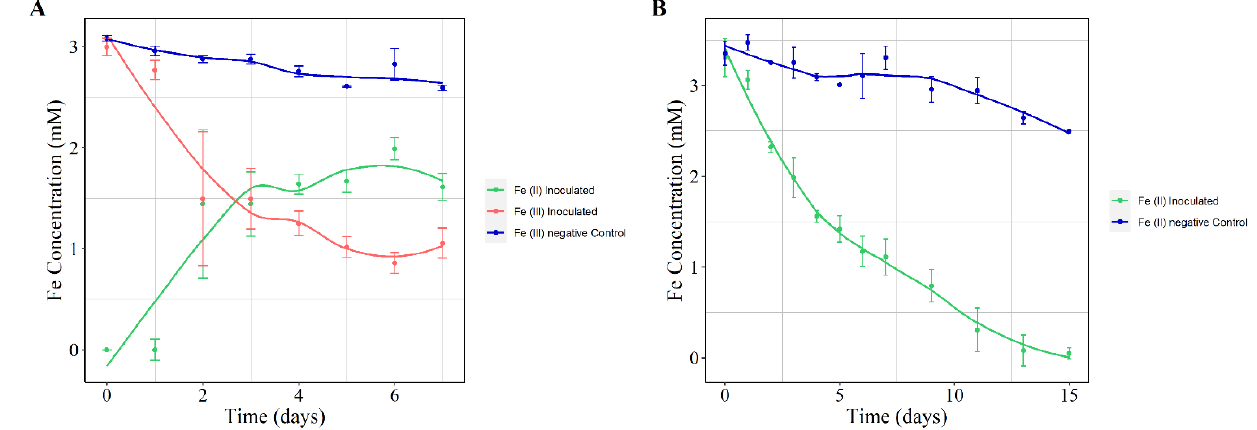
Figure 3. Reduction ( A ) and oxidation ( B ) of Fe of Shewanella sp. T2.3D-1.1. ( A ) In blue, concentration of Fe 3+ in the control bottle; in red, evolution of Fe 3+ in the cultures; in green, concentration of re- duced Fe 2+ in the inoculated cultures. ( B ) In blue, concentration of Fe 2+ in the control (absence of microorganism); in green, concentration of Fe 2+ in the inoculated